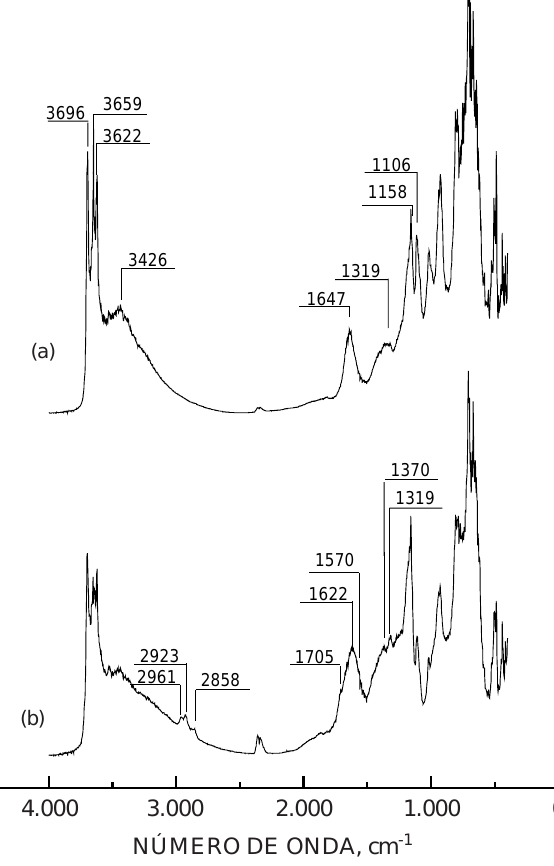
Figura 3. Espectro de DRIFT do Latossolo Roxo natural a) antes e b) depois da adsorção de ácido húmico extraído de